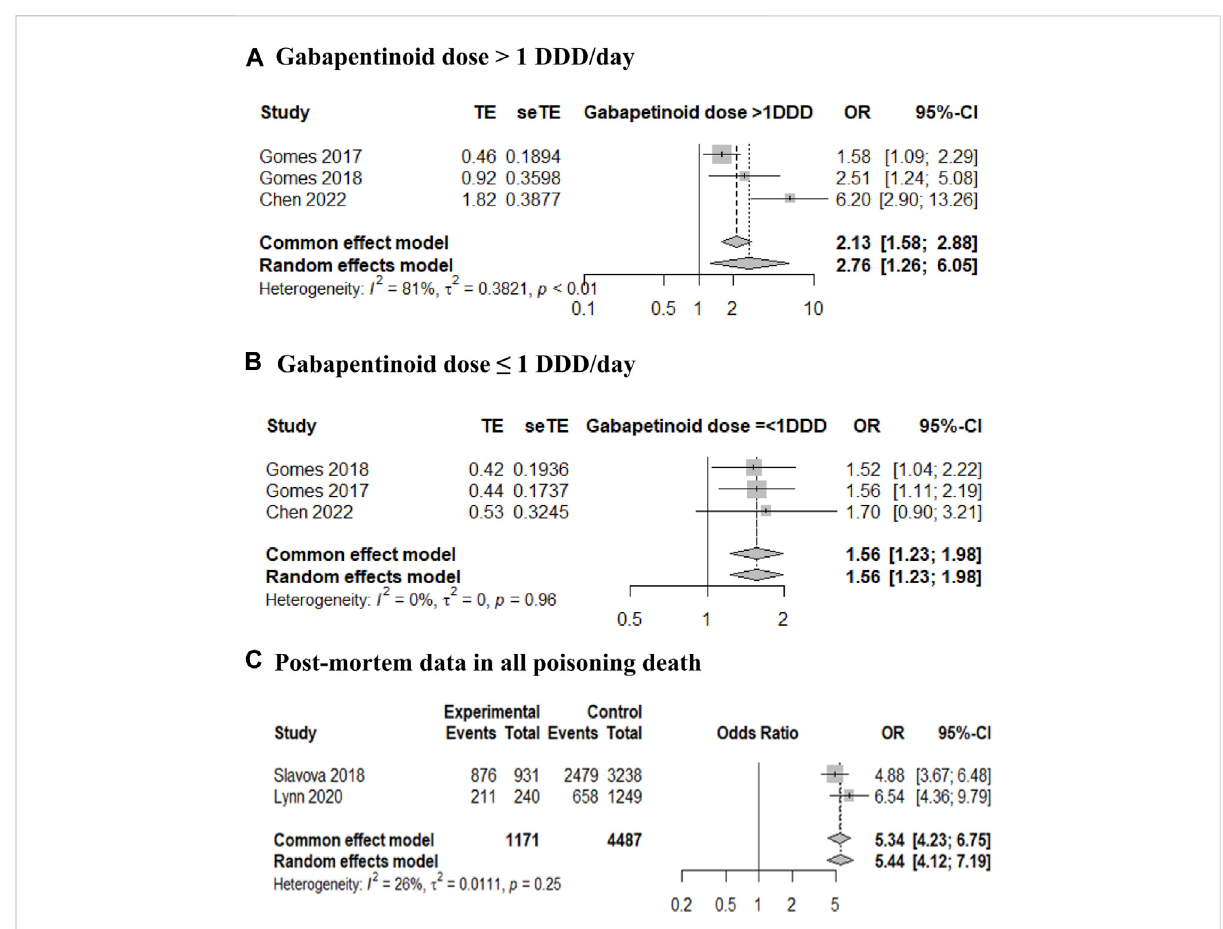
FIGURE 2 Forest plot of the mortality risk in opioid and gabapentinoid combination therapy compared with that in opioid therapy. (A) Gabapentinoid dose > 1 de fi ned daily dose (DDD)/day, (B) gabapentinoid dose ≤ 1 DDD/day, and (C) post-mortem data in all poisoning deaths.